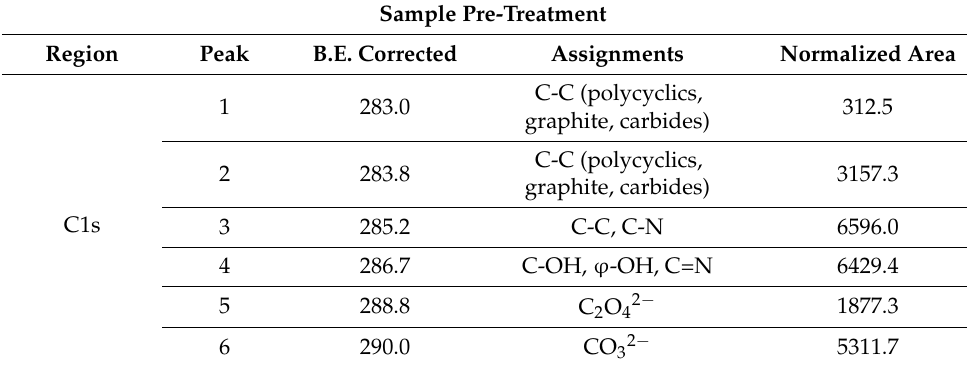
Table 2. Corrected BE, normalized area and assignments for the C1s regions: post-treatment sample.